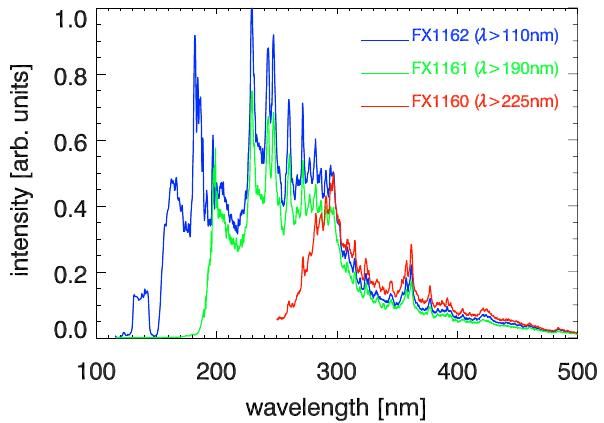
Fig. 3. Time series of currents recorded with the ECOMA parti- cle detector at a rate of 100kHz and a resolution of 16 bit. Dia- monds mark current peaks caused by photoelectrons reaching the electrode shortly after the firing of corresponding flash lamps. Dif- ferent colours mark the different flash lamp types as indicated in the insert. In the following, the time series of photoelectron peaks are denoted as photoelectron currents for